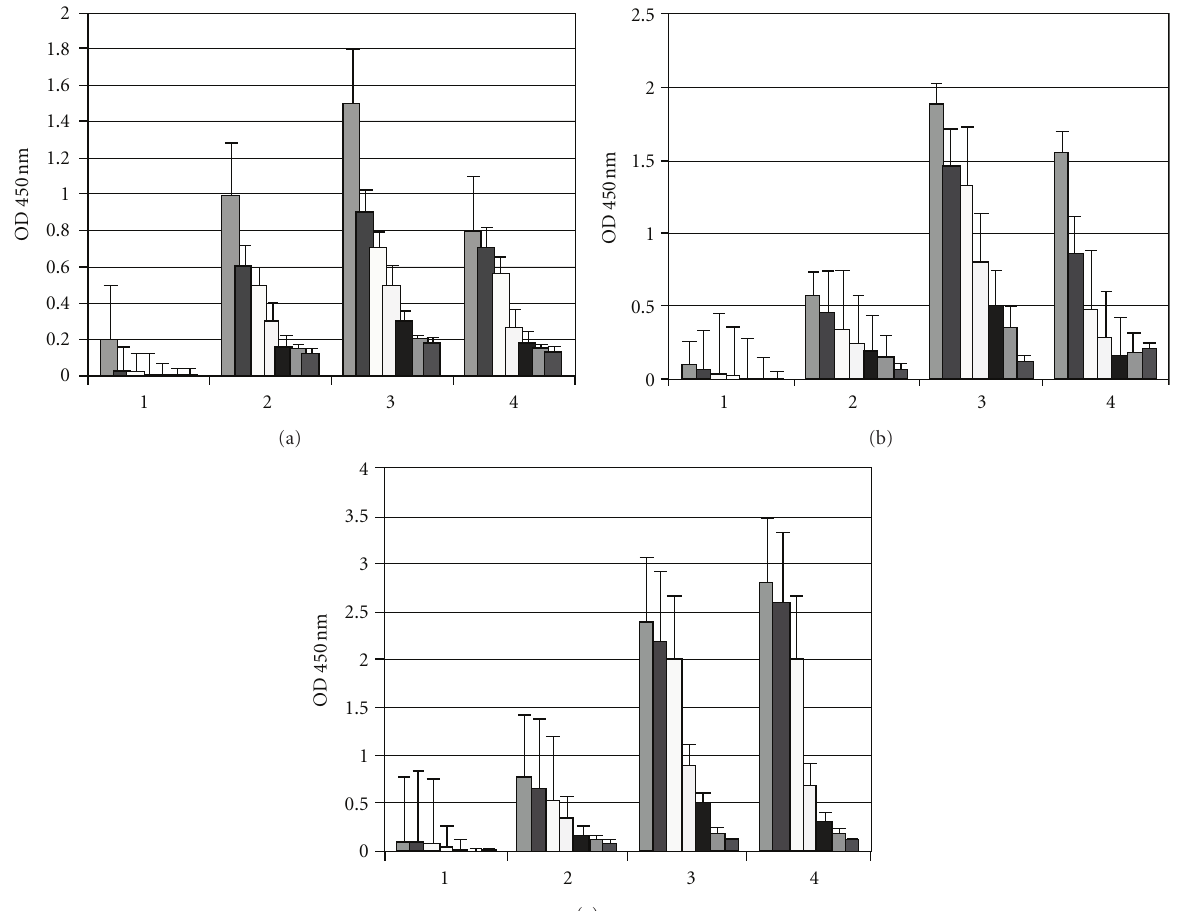
Figure 2: Antigen-specific IgG, IgM, and IgA antibody responses in mice sera after i.n. immunization with native OMPs of N. meningitidis determined by ELISA at 28 days with Stx1, Stx2, or CT as adjuvants. Results are shown as mean titers and error bars indicate standard deviations from the mean. (a) Sera pooled from nine mice immunized with OMPs and stx1; (b) sera pooled from eight mice immunized with OMPs and stx2; (c) sera pooled from ten mice immunized with OMPs and CT. (1) IgG, IgM, and IGA of normal mice; (2) IgG; (3) IgM; (4) IgA. Each scale bar represents the mean ± SE of nine to ten mice per group in an experiment representative of two separate experiments. (a) OMPs and Stx1- IgG, IgM, and IgA containing formulations versus normal sera ( P < 0 . 05); (b) OMPs and Stx2 IgG, IgM, and IgA containing formulations versus normal sera ( P < 0 . 001); (c) OMPs and CT IgG, IgM, and IgA containing formulations versus normal sera ( P < 0 .